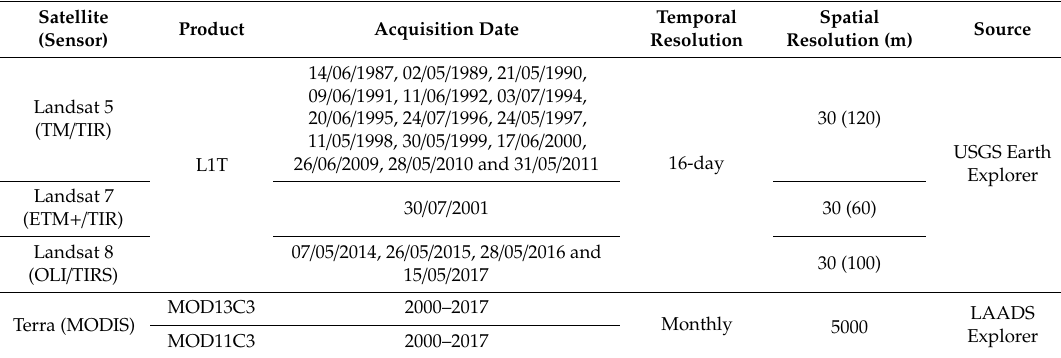
Table 1. Data layers used in this study details. TM: Thematic Mapper; TIRS: Thermal Infrared Sensor; ETM + : Enhanced Thematic Mapper Plus (ETM + ); LAADS: Atmosphere Archive and Distribution System; USGS: United States Geological